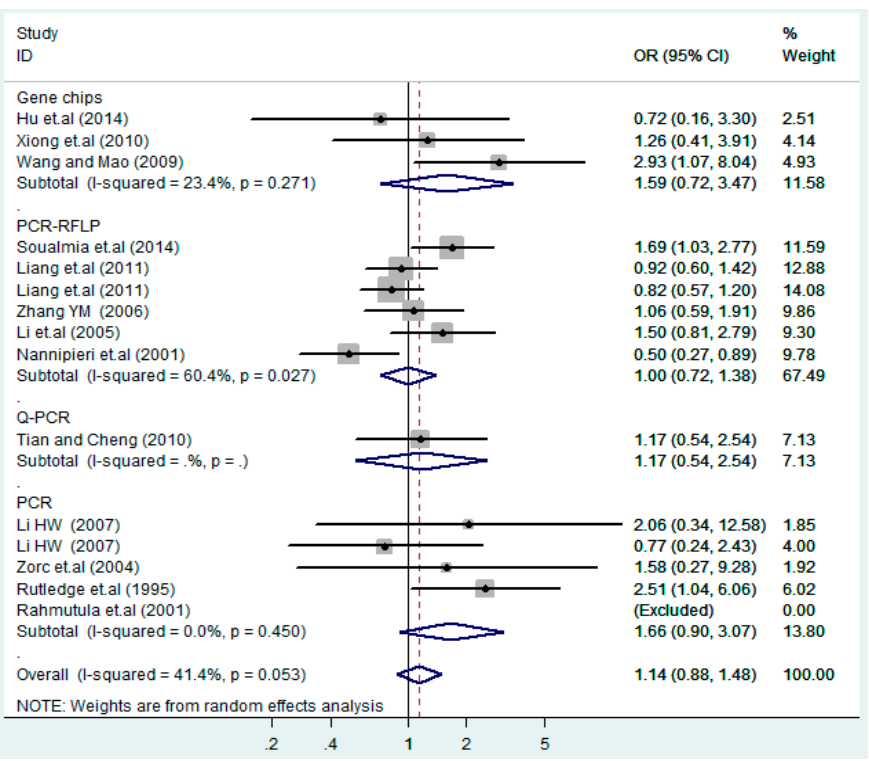
Figure 21. Subgroups of genotyping methods of T2238C co-dominant model-2 (CC vs. TT).